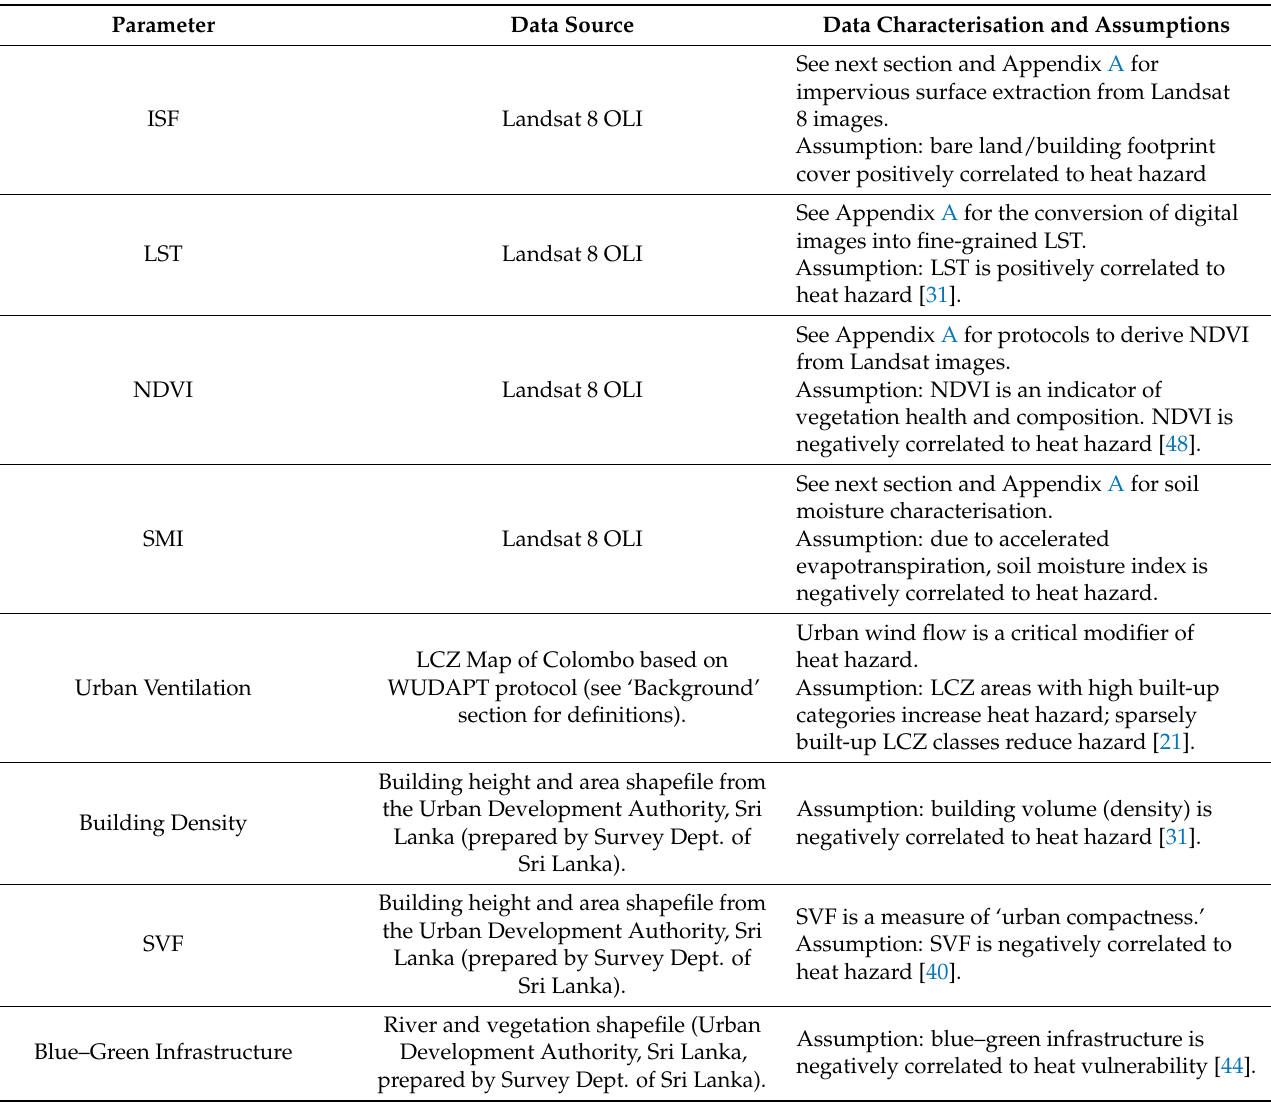
Table 1. Physical environment and climate data, characterisation, and assumptions.